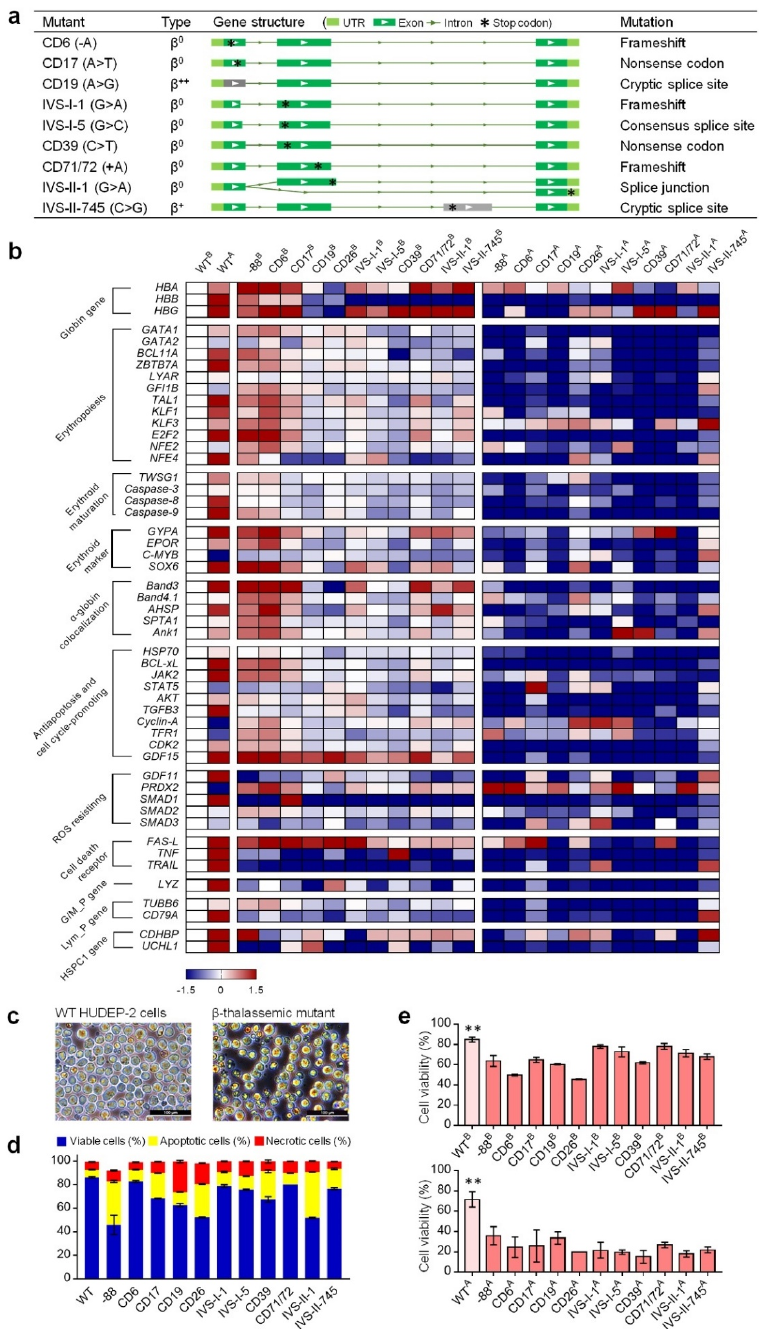
Figure 4. Phenotyping of the HUDEP-2 cells with beta-thal mutations. ( a ) Transcript structures of the HBB gene in beta-thal cells. The light green box indicates the UTR regions, green and gray boxes indicate the exon, the line indicates the intron, and the asterisk indicates the premature stop codon. Two isoforms with different lengths of HBB transcript were detected from IVS-II-1 cells. ( b ) Heatmap qPCR gene expression analysis. Superscript B and A mean before and after erythroid dif- ferentiation, respectively. All gene expression values were normalized to the GAPDH gene. The navy and crimson blocks indicate the genes are significantly downregulated and upregulated, re- spectively. ( c ) Microscopic examination of wildtype (WT) HDUEP-2 and beta-thal cells. More ne- crotic cells and debris are observed in beta-thal cells cultured in vitro. Scale bar: 100 μ m. ( d ) Apop- tosis analysis of WT HUDEP-2 and beta-thal cells cultured in vitro. x -axis shows different beta-thal cells, and y -axis shows the percentage of viable, apoptotic, and necrotic cells (mean ± SEM value). ( e ) Cell viability analysis of WT HUDEP-2 and beta-thal cells. B and A mean before and after erythroid differentiation, respectively. x -axis shows different beta-thal cells, and y -axis shows the percentage of cell viability (mean ± SEM value). ** means the p -value ≤ 0.01 ( t -test). Next, we extracted the mRNA from WT HUDEP-2 and the beta-thal cells before and after erythroid differentiation (ED) (Figure S3c). Quantitative Real-Time PCR (qPCR) was performed to quantify the relative expression of the 51 genes associated with erythropoi- esis and erythroid maturation [21,26–39]. The expression values were normalized with the housekeeping gene GAPDH , and the changes in gene expression were calculated (Table S6). a. WT vs . beta-thal before ED: value = ln (beta-thal B /WT B ); b.